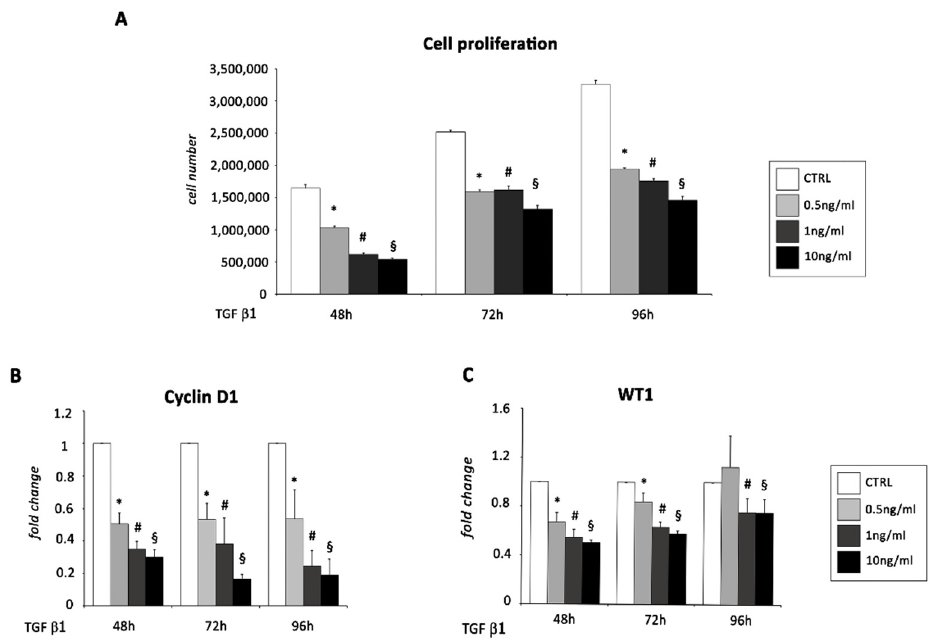
Figure 3. EMCs undergo EMT after exposure to TGF β 1 . Growth curve of EMCs after ( A ) 48 h, 72, and 96 h of culture and 0.5, 1, and 10 ng/mL of TGF β 1 stimulation, compared to untreated conditions. Data represent means ± SEM of three Scheme 0. for 0.5 ng/mL of TGF β 1; #, p < 0.05 for 1 ng/mL of TGF β 1; §, p < 0.05 for 10 ng/mL of TGF β 1 vs. control conditions (CTRL). mRNA expression levels of ( B ) Cyclin D1 and ( C ) WT1 in EMCs following exposure to 0.5, 1, and 10 ng/mL of TGF β 1 for 48, 72, and 96 h, determined by real time PCR. The bar graphs show fold increases in expression of the studied genes in EMCs with respect to control untreated cells, set at 1. Data were normalized to GAPDH, a housekeeping gene, and represent means ± SEM of three separate experiments, each repeated in triplicate. *, p < 0.05 for 0.5 ng/mL of TGF β 1; #, p < 0.05 for 1 ng/mL of TGF β 1; §, p < 0.05 for 10 ng/mL of TGF β 1 vs. control conditions (CTRL).